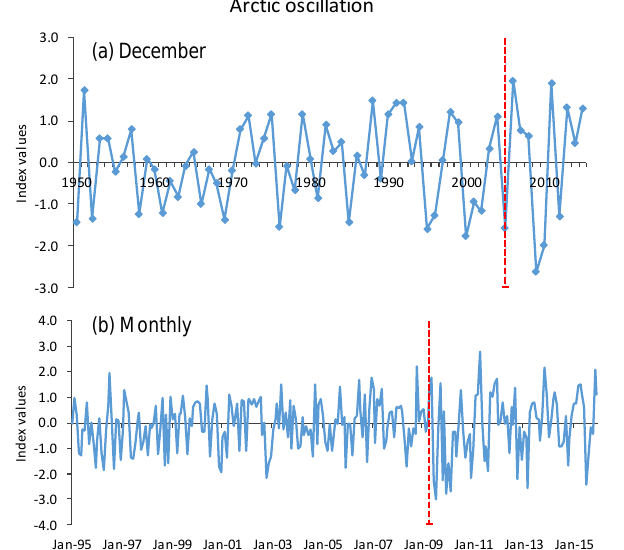
Figure 9. The Arctic oscillation index: (a) December values, 1950– 2015, with a change point in 2005 detected by SRSD (0.1, 25, 2); (b) monthly values, January 1995–December 2015, with a change point in April 2009 detected by SRSD (0.05, 120, 2) and